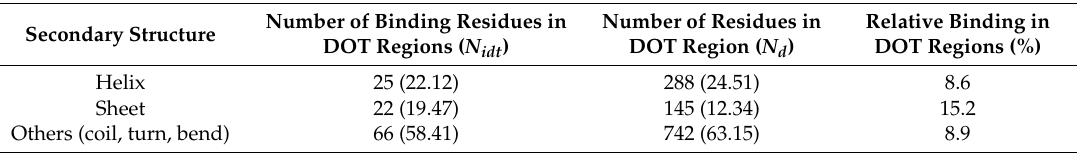
Table 1. Secondary structure of all DOT residues and residues binding with RNA in DOT regions in the NR3.5 dataset.